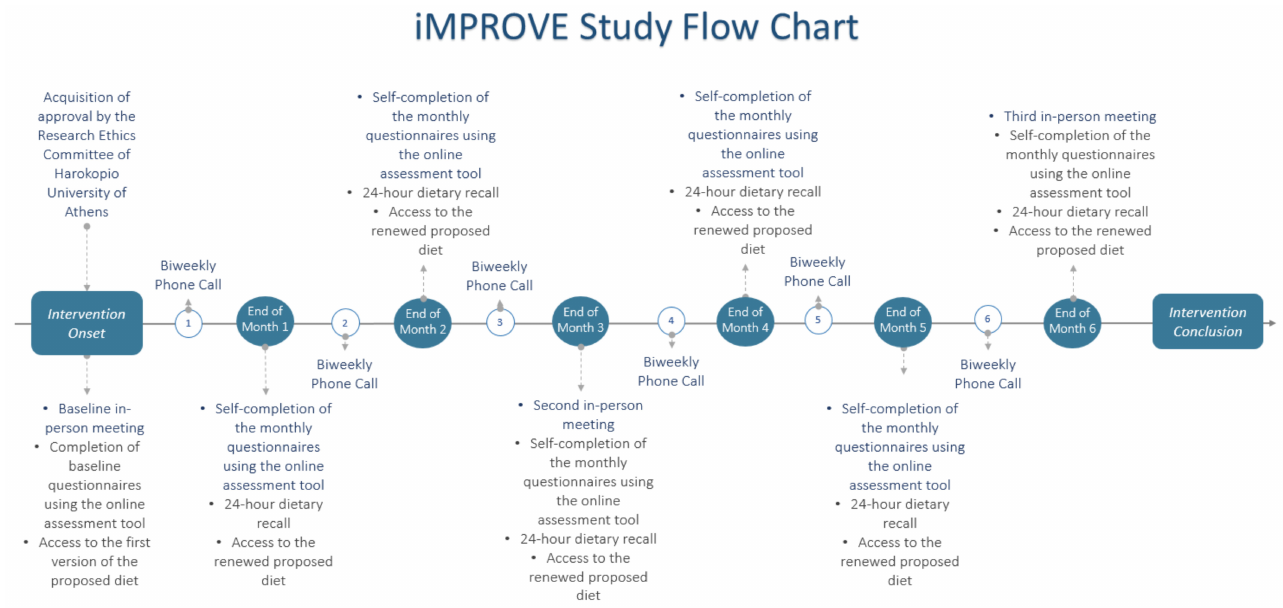
Figure 1. Flow chart of the iMPROVE Study. After completion of the baseline meeting, each participant was randomly allocated to one of the two proposed dietary intervention groups. Those referred either to a dietary regimen high in carbohydrates/low in fat, with 60% of energy intake deriving from carbohydrates, 18% deriving from protein, and 22% deriving from fat, or a dietary regimen high in protein, with 40% of the total energy intake coming from carbohydrates, 30% deriving from protein, and 30% deriving from fat. Nutritional needs for each participant were calculated using the Mifflin equation and adjusted for their reported physical activity level (PAL). According to the guidelines of the National Institutes of Health (NIH) [11], optimal weight loss should take place aiming at a mean weight loss of 0.5 to 1 kg per week, which is translated to a 7500 kcal reduction in the individual’s weekly energy intake, or a 500 kcal reduction on a daily basis. Therefore, daily individual nutritional needs for each participant were further reduced by 500 kcal. The team of Harokopio University of Athens created three categories of proposed hypocaloric diets with a mean energy content of 1500 kcal, 1800 kcal, or 2000 kcal. Six different versions of the proposed diets, one for each intervention month, were created to allow for monthly renewal of the proposed diets, based on the participants’ observed weight loss and dietary habits and/or tastes. The proposed diets concerned a 7-day pattern to be repeated for each month and mainly adhered to the Mediterranean pattern, including the daily consumption of 3 to 5 portions of fruit and vegetables and 1 to 2 portions of dairy products and the weekly consumption of 2 to 3 portions of grains, fish, and chicken, while limiting the consumption of red meat to 1 meal per